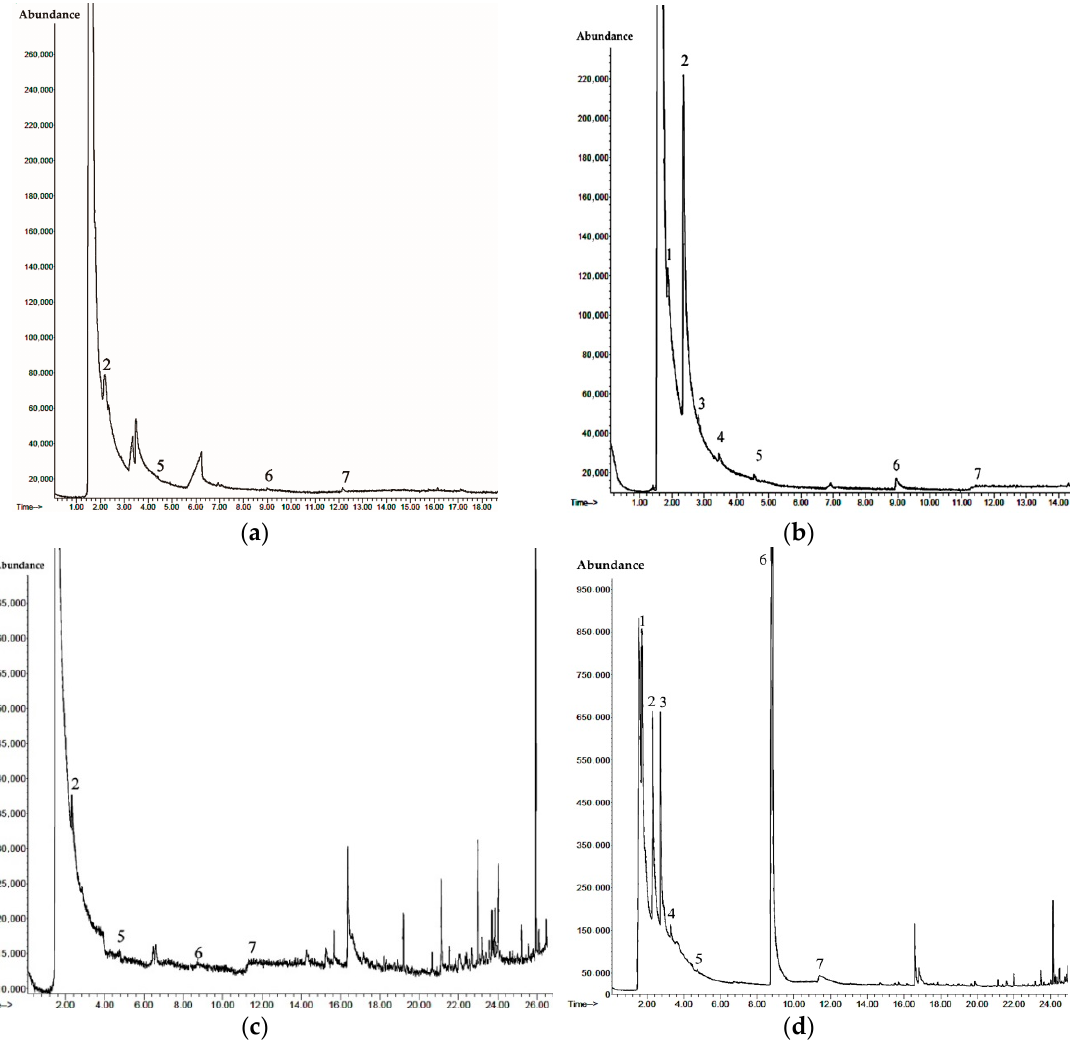
Figure 5. GC ‐ MS data of degradation intermediates: ( a ) final degrading total ion chromatograms (TIC) of M12 strain in aqueous MSM; ( b ) final degrading TIC of control sample in aqueous MSM; ( c ) final degrading TIC of P4 strain in SS; ( d ) final degrading TIC of control sample in SS.